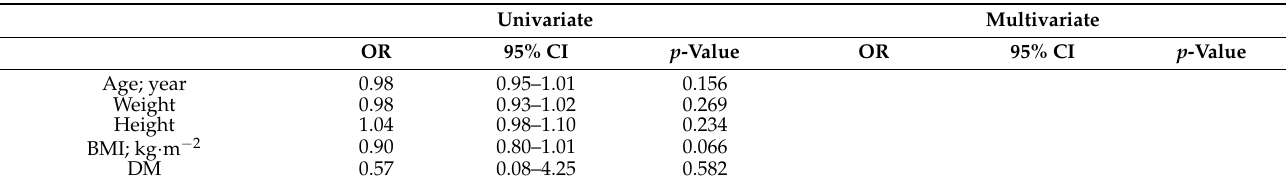
Table 2. Univariate and multivariate logistic regression analysis of 5-year mortality.